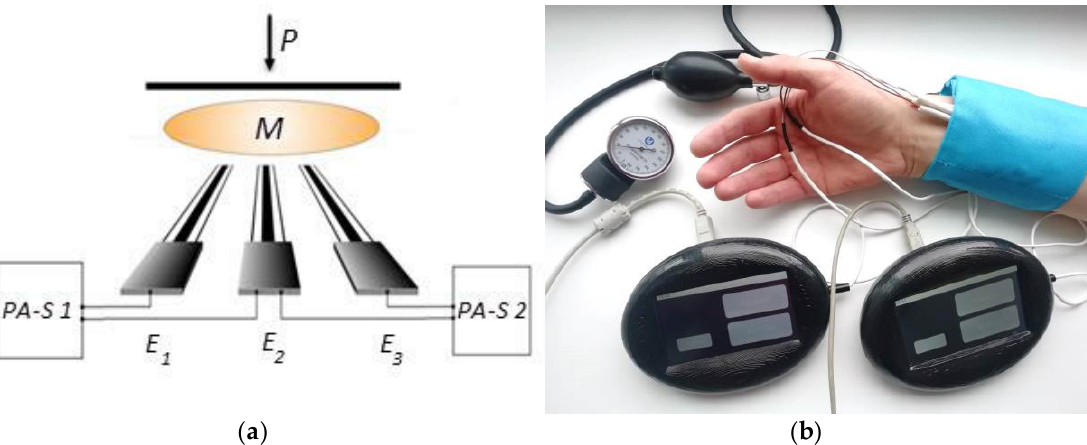
Figure 2. Measuring scheme ( a ) and photo illustrating the process of skin antioxidant activity (AOA) measurement ( b ). E 1 – E 3 : electrodes; M: membrane; PA-S 1 and PA-S 2: potentiometric analyzers; P: load.